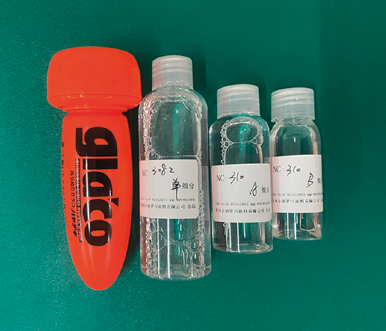
Figure 16: Surface treatment agent.